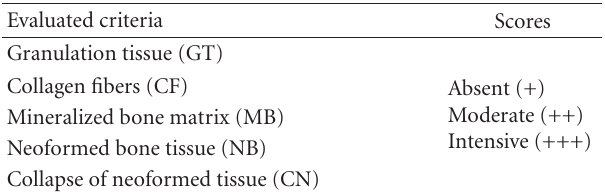
Table 1: Criteria and score evaluation by GE’s optical